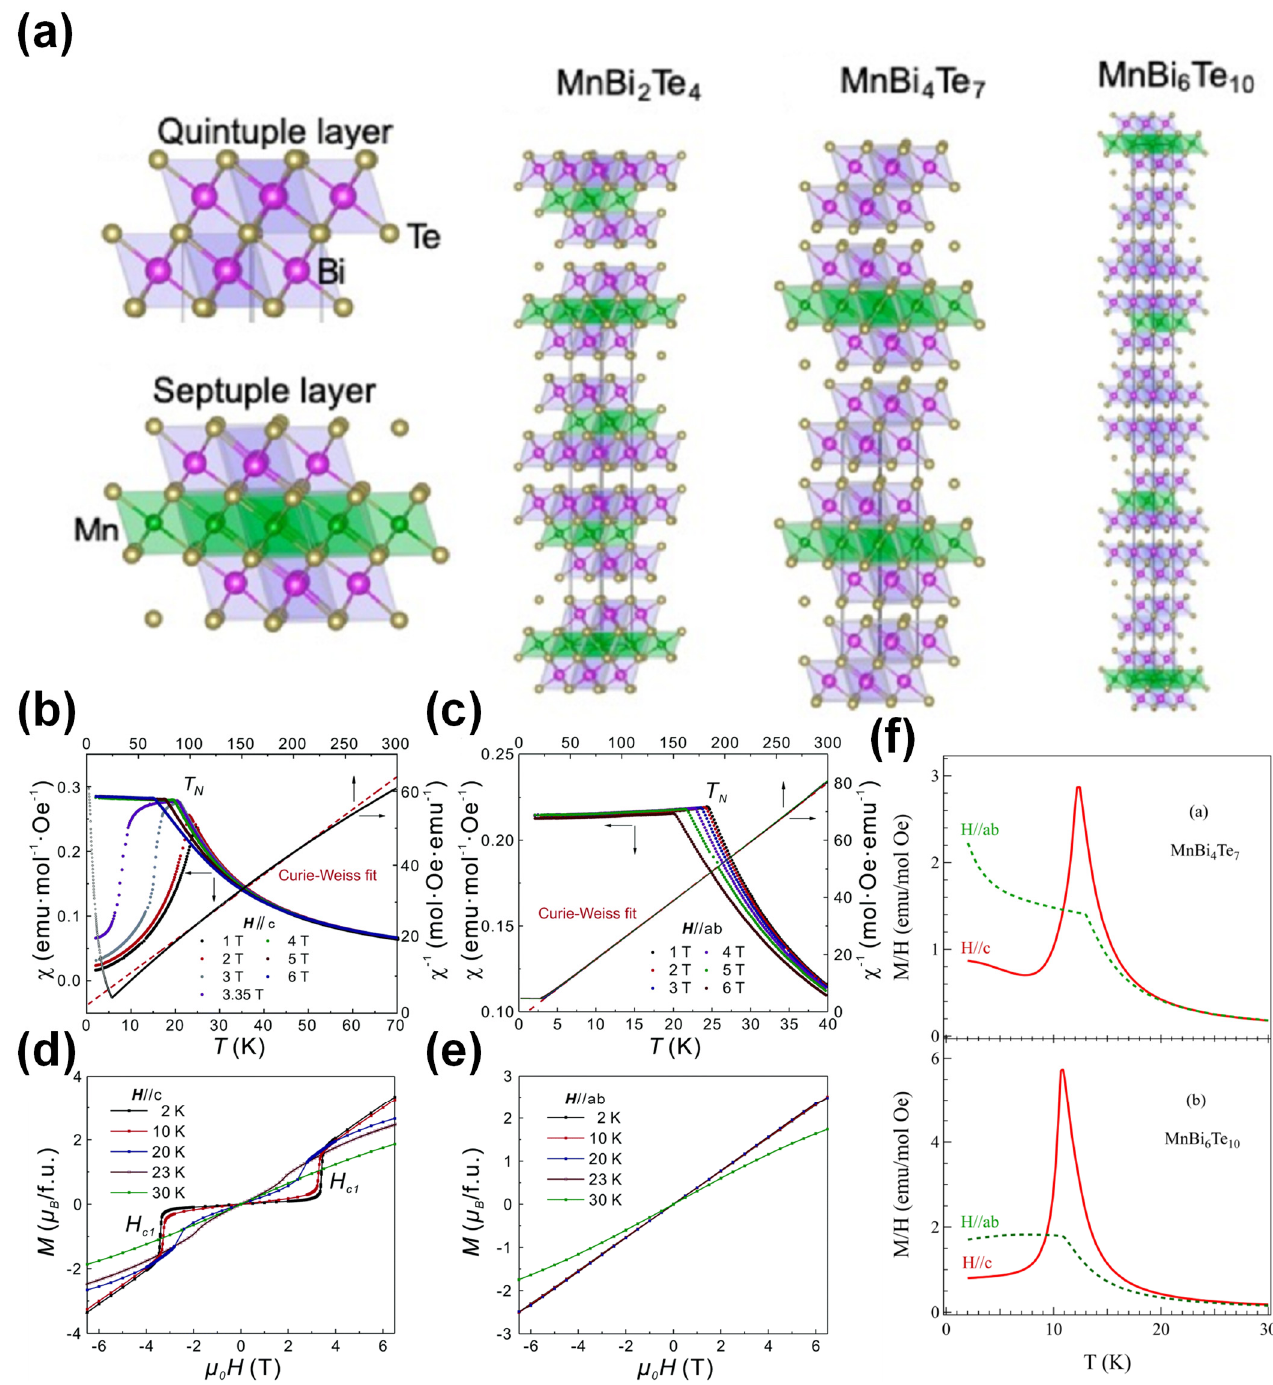
Figure 7. ( a ) Structure units of MnBi 2n Te 3n+1 . Reused with permission from [176] . ( b , c ) Magnetic properties of single-crystal MnBi 2 Te 4 . Temperature dependence of magnetic susceptibility for the MnBi 2 Te 4 single crystal and inverse magnetic susceptibility as a function of temperature. The mag- netic field is out-of-plane ( a ) and in-plane ( b ), respectively. Reused with permission from [173] . ( d , e ) Field dependence of magnetization for the MnBi 2 Te 4 crystal measured at different tempera- tures. The magnetic field is out-of-plane ( d ) and in-plane ( e ), respectively. Reused with permission from [173] . ( f ) Temperature dependence of magnetic susceptibility under an applied magnetic field of 250 Oe perpendicular ( H // ab ) and parallel ( H // c ) to the crystallographic c -axis for MnBi 4 Te 7 (upper panel) and MnBi 6 Te 10 (lower panel). Reused with permission from